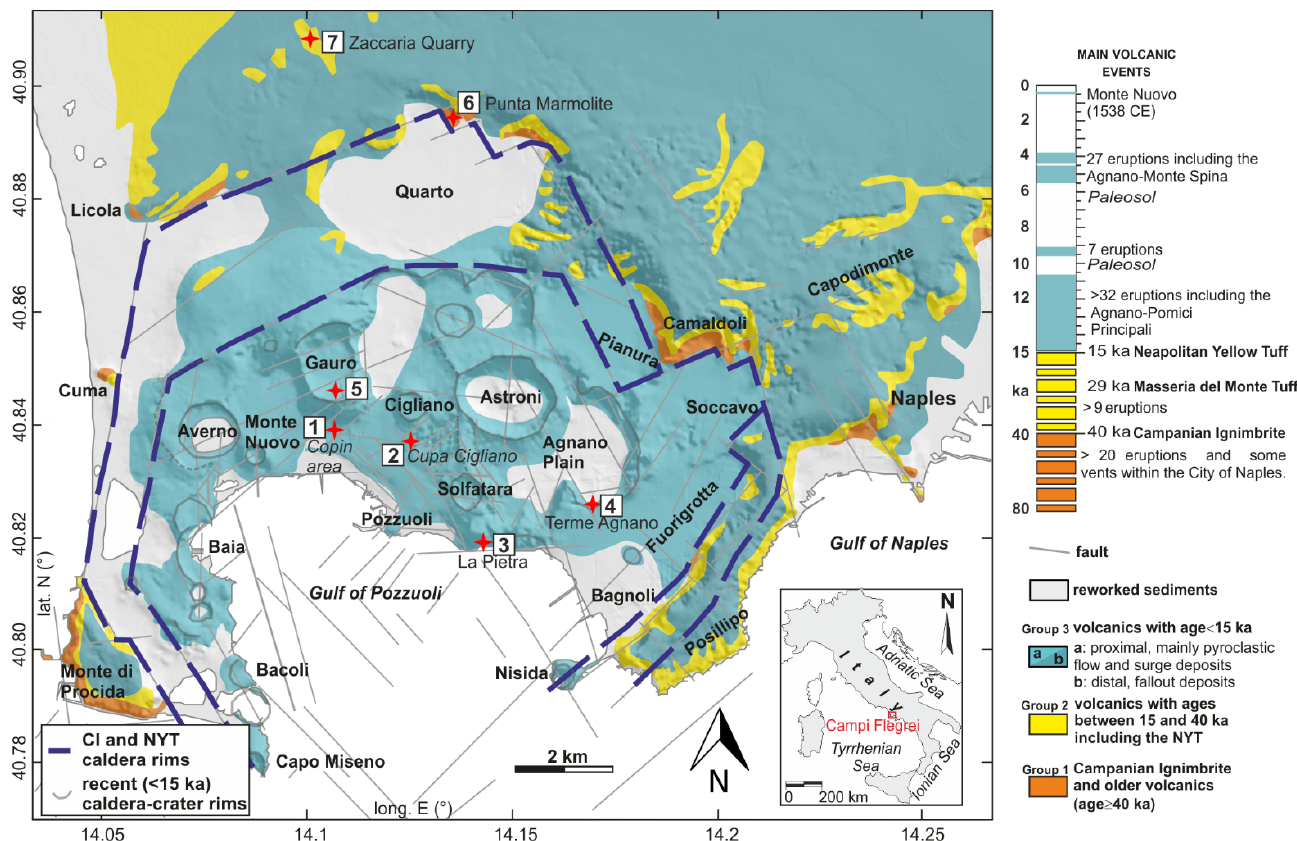
Figure 1. Geological sketch of the Campi Flegrei shows the sites of the studied paleo-liquefaction structures (modified after [19]).